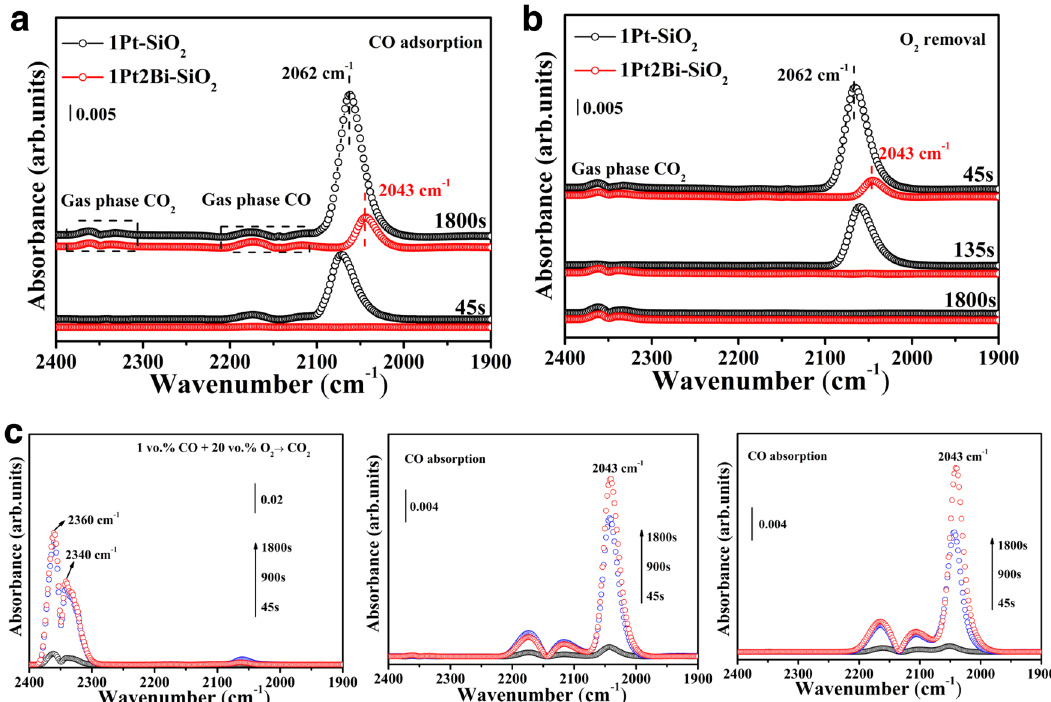
Fig. 7 The CO adsorption on Pt − [O] x − Bi active site. In-situ DRIFTS study of a CO adsorption and b O 2 removal on Pt/PtBi-SiO 2 samples; c In-situ DRIFTS in the mode: “ CO adsorption → reaction conditions (1% CO/ 20% O 2 /N 2 fl ow) at 200 °C → CO adsorption ” on 1Pt2Bi-SiO 2 without catalyst replacement and air exposure. (The catalysts were pretreated in-situ at 210 °C under H 2 fl ow in the DRIFTS reaction cell before data collection; CO fl ow rate: 30 mL min − 1 ; catalyst mass: 20 mg; temperature: 100